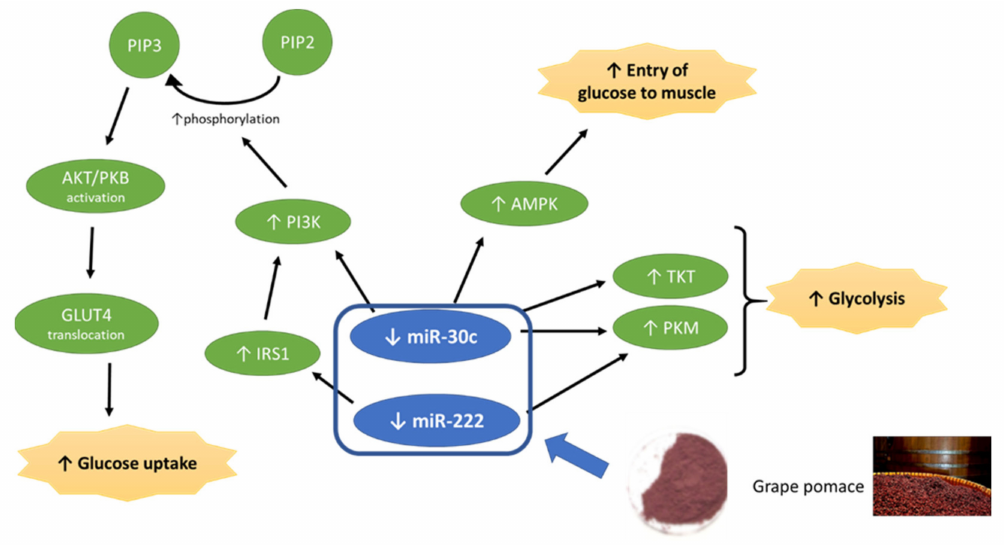
Figure 4. Effects of grape pomace on miR-30c and miR-222 and potential consequences in metabolic pathways involved in glycaemic